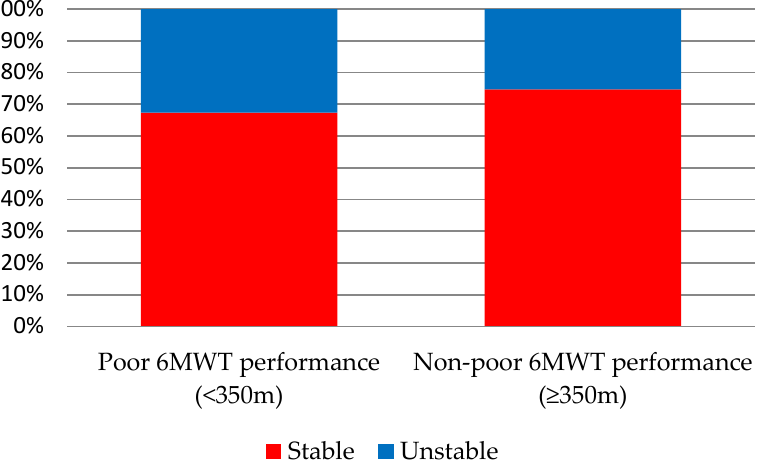
Figure 1. Stability of 6-min walk test (6MWT) performance after 2 years, according to baseline status. Table 2. Multivariate regression models show the predictive strengths of clinical and pulmonary factors for poor 6MWT performance ( < 350 m) a